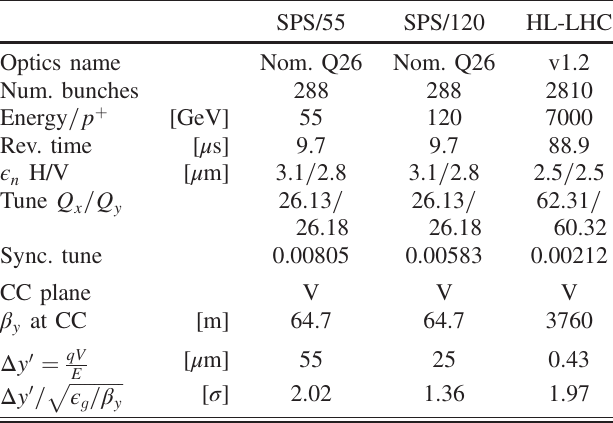
TABLE I. Key parameters of the S IX T RACK simulations for the three